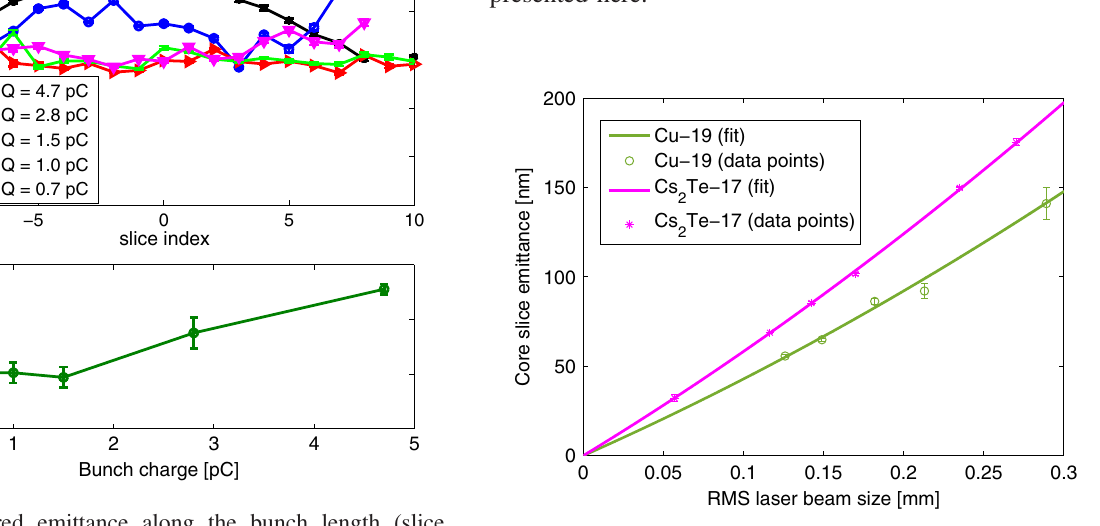
FIG. 4. Examples of normalized intrinsic emittance measure- ments for two of the cathodes. In the Cs 2 Te-17 case accelerator conditions were more stable than for Cu-19, resulting in a smaller error on the normalized intrinsic